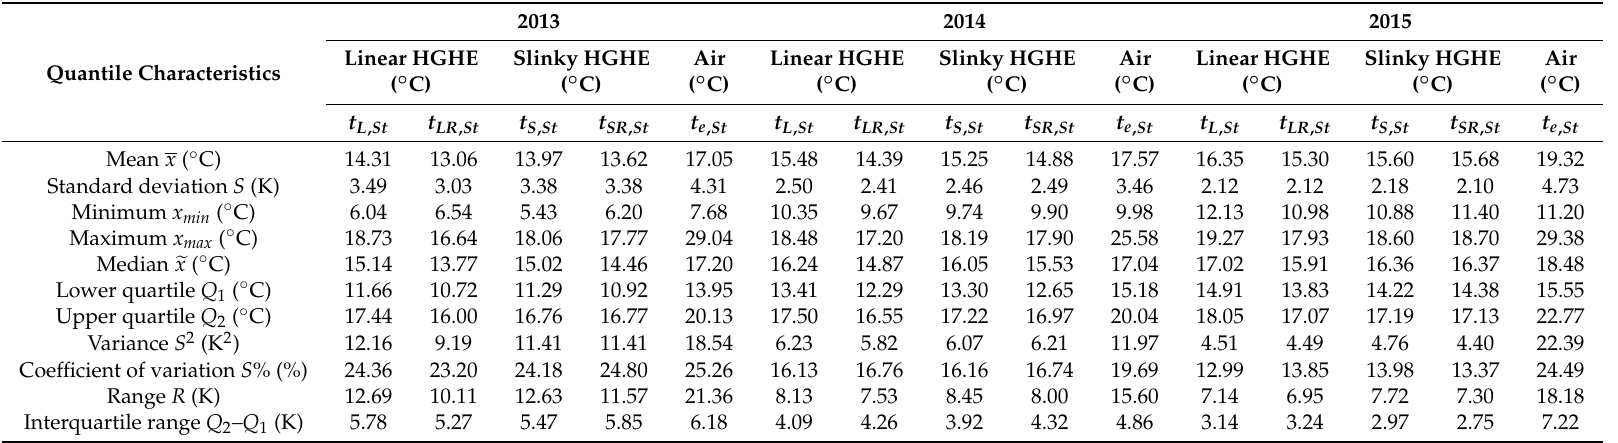
Table 2. Quantile characteristics of sets of average daily temperatures of ground masses in the proximities of HGHEs and ambient temperatures during periods of HGHE stagnation.